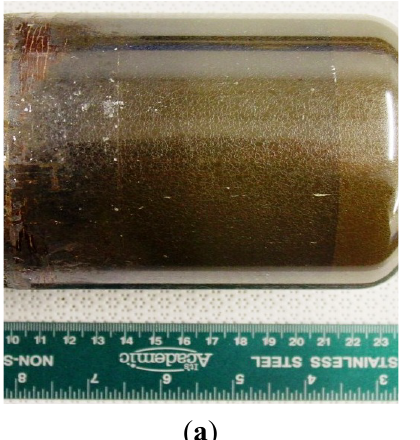
Figure 2. A 100-mm diameter Pb(Mg